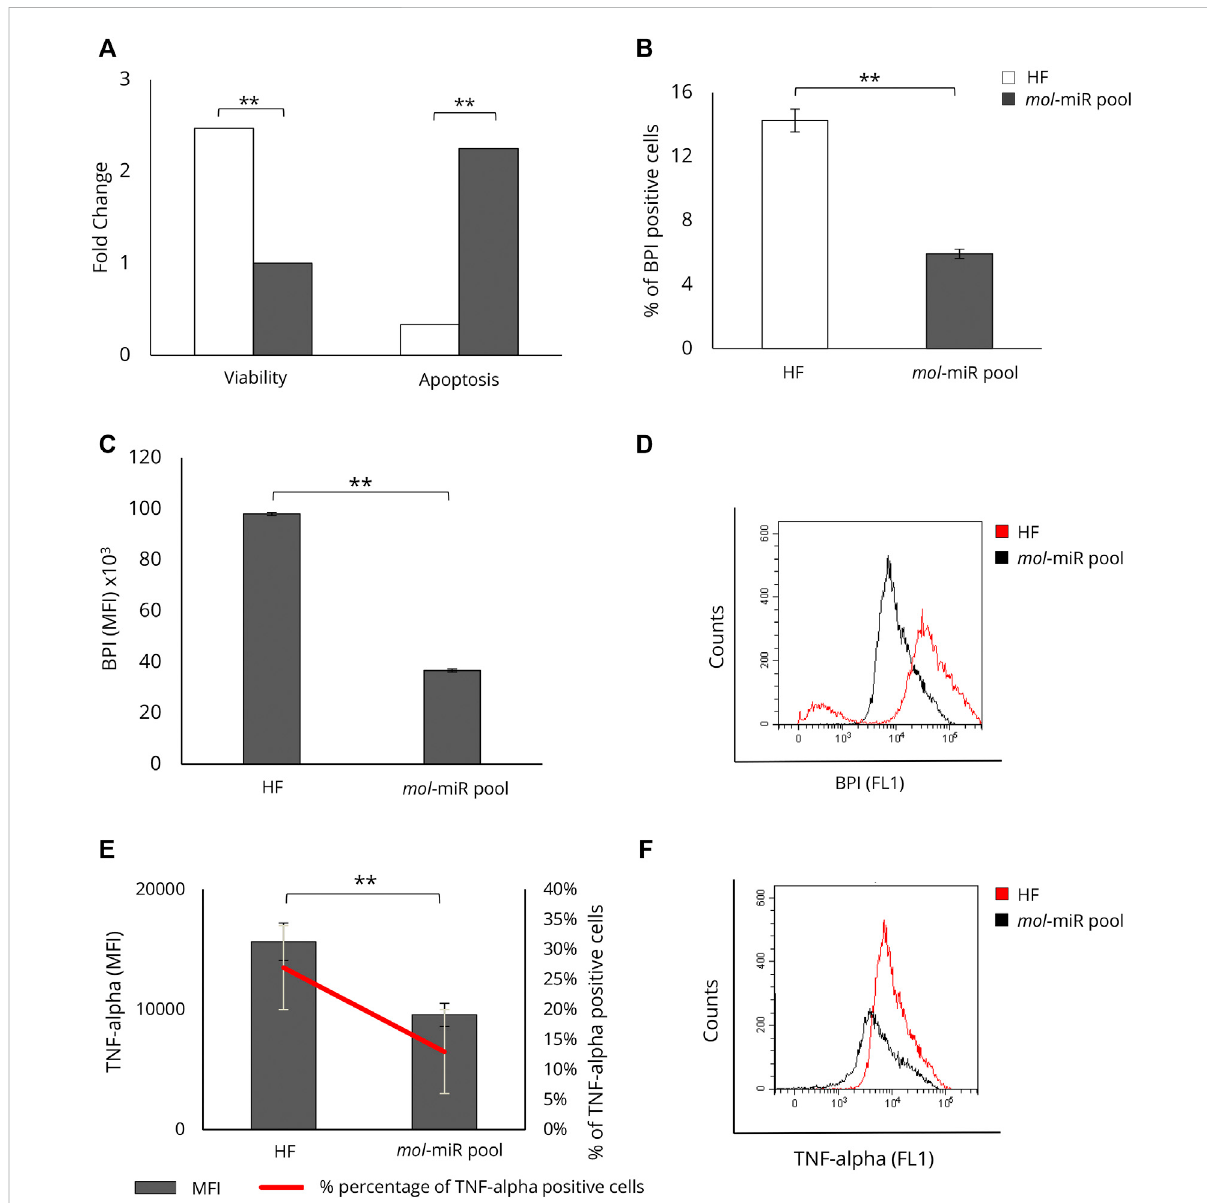
FIGURE 3 Characterization of mol -miR pool effect on HepG2 viability, apoptosis, and lipid accumulation. (A) Effect of mol -miR pool transfection on apoptosis and viability in HepG2 cells. (B) Percentage of BPI positive HepG2 cells treated with mol -miR pool. (C) MFI of BPI positive HepG2 cells treated with mol -miR pool. (D) Representative overlay histogram of lipid content in HepG2 cells treated with mol -miR pool. (E) MFI (black column) and percentage (red line) of TNF-alpha positive cells. (F) Representative overlay histogram of TNF-alpha in HepG2 cells treated with mol